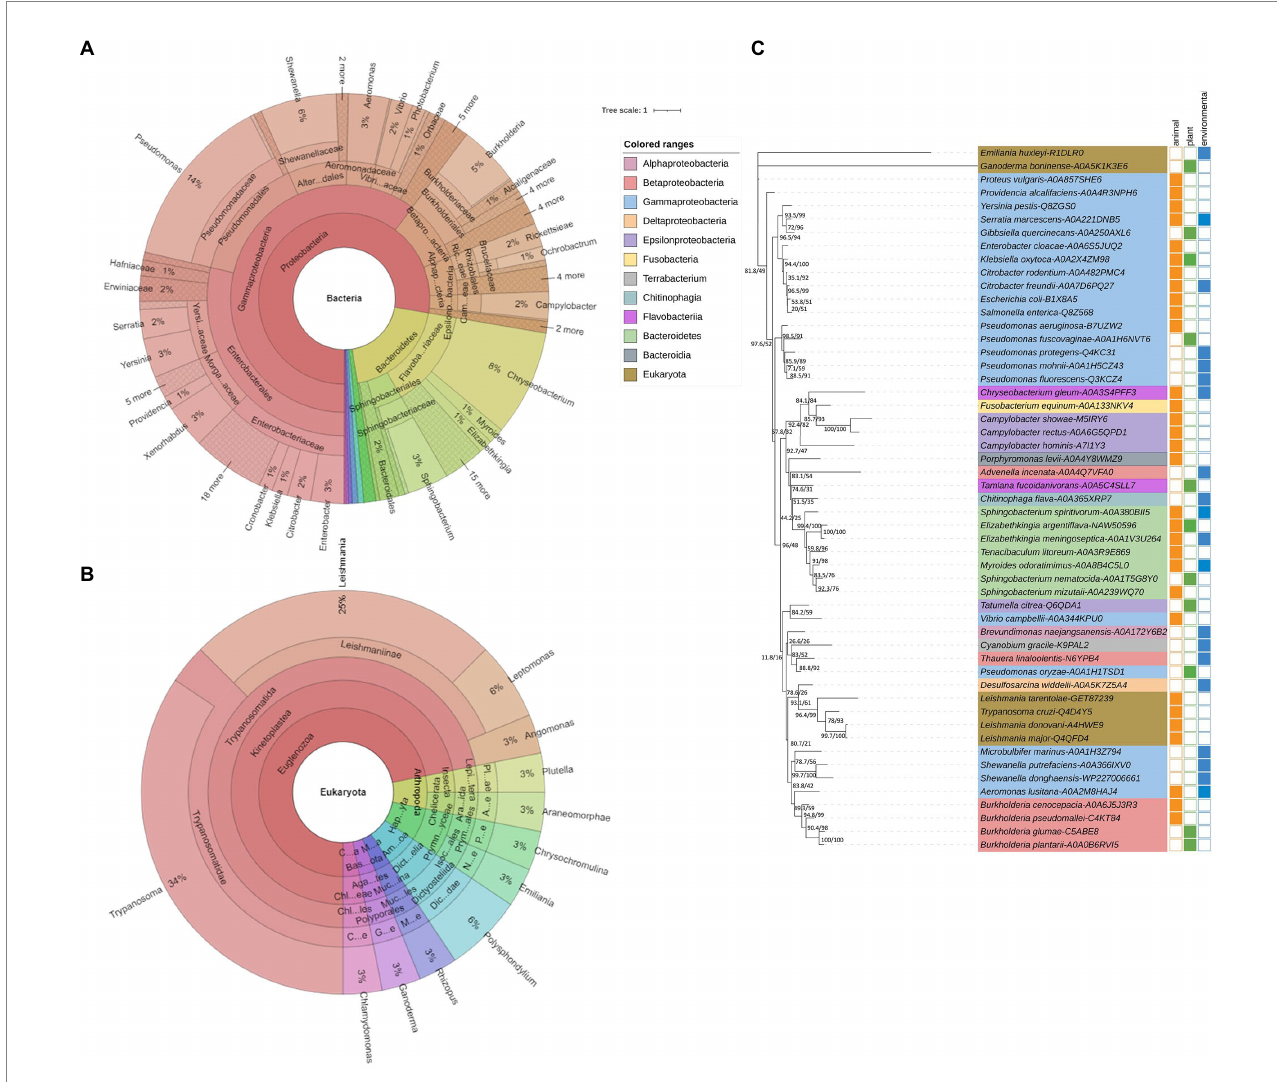
FIGURE 2 Taxonomic distribution of organisms containing ecotin orthologs. (A) More than six hundred species are present throughout the Tree of Life and encode at least one ecotin homolog. Protein sequences were extracted from InterPro (query: IPR036198) and validated as belonging to the same orthogroup with eggNOG-Mapper (E-value: 0.0001, minimum bit score: 60, % identity >40, query coverage >20%; Blum et al., 2021; Cantalapiedra et al., 2021). Orthology assignments were double checked in EggNOG database using EggNOG OGs. Remaining protein sequences were checked by the presence of ecotin domains as predicted by Pfam using eggNOG-Mapper (Mistry et al., 2021). One sequence for each species was retained, after which they were further aligned based on their amino acid sequence using MUSCLE (Edgar, 2004) in MEGA11 (Tamura et al., 2021). (A) Among Bacteria , the class of Proteobacteria (502 species) represents the majority of ecotin-expressing species. Note that this analysis is not comprehensive and homologs may have been missed due to biases in database representation and/or search parameters. (B) Among the Eukaryotes, both the Trypanosoma and Leishmania species, belonging to the Kinetoplastida class, contain over 10 species that are causative agents of several and widespread infectious diseases. The figure was made using KronaTools 2.7.1 (Ondov et al., 2011). (C) Unrooted phylogenetic tree of ecotin orthologs. Only one representative sequence per identified EggNOG OG was retained. Sequences were aligned based on their amino acid sequences using MUSCLE (Edgar, 2004) in MEGA11 (Tamura et al., 2021). A phylogenetic tree was constructed using the Maximum Likelihood (ML) method and LG + G4 substitution model in IQ-TREE (Minh et al., 2020). The SH-aLRT support (%) and the percentage of replicate trees in which the associated taxa cluster together in the bootstrap test (1,000 replicates) are shown next to the branches. The scale bar indicates the number of substitutions per site. Additional annotations are presented showing which taxa contain animal pathogenic (orange squares), plant-associated (green squares), and environmental (blue squares)